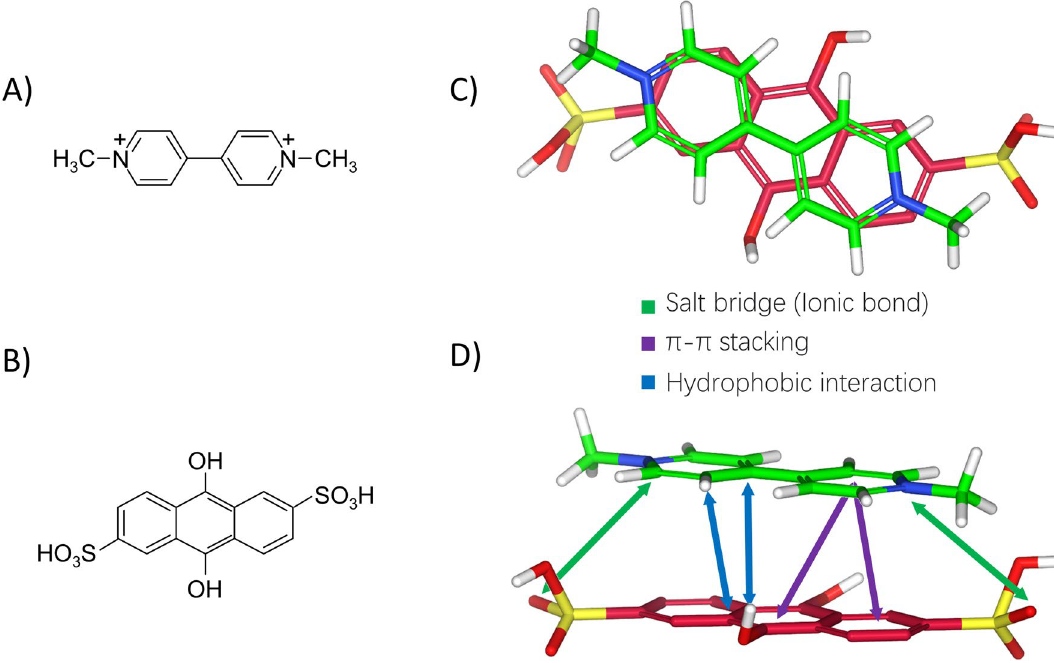
Figure 1. Complexation of PQ by AH 2 QDS. ( A , B ) Structures of PQ ( A ) and AH 2 QDS ( B ). ( C , D ) Complexes of PQ and